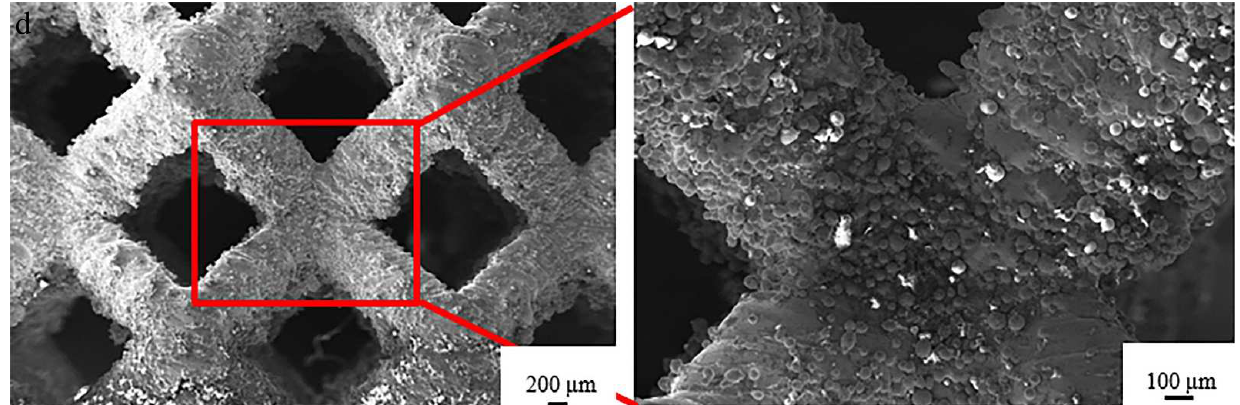
Figure 17. SEM photos of two kinds of bone scaffold: ( a ) finite element simulation of deformation of conventional BCC structure, ( b ) finite element simulation of deformation of optimized BCC structure, ( c ) surface morphology of conventional BCC structure, and ( d ) surface morphology of optimized BCC structure.